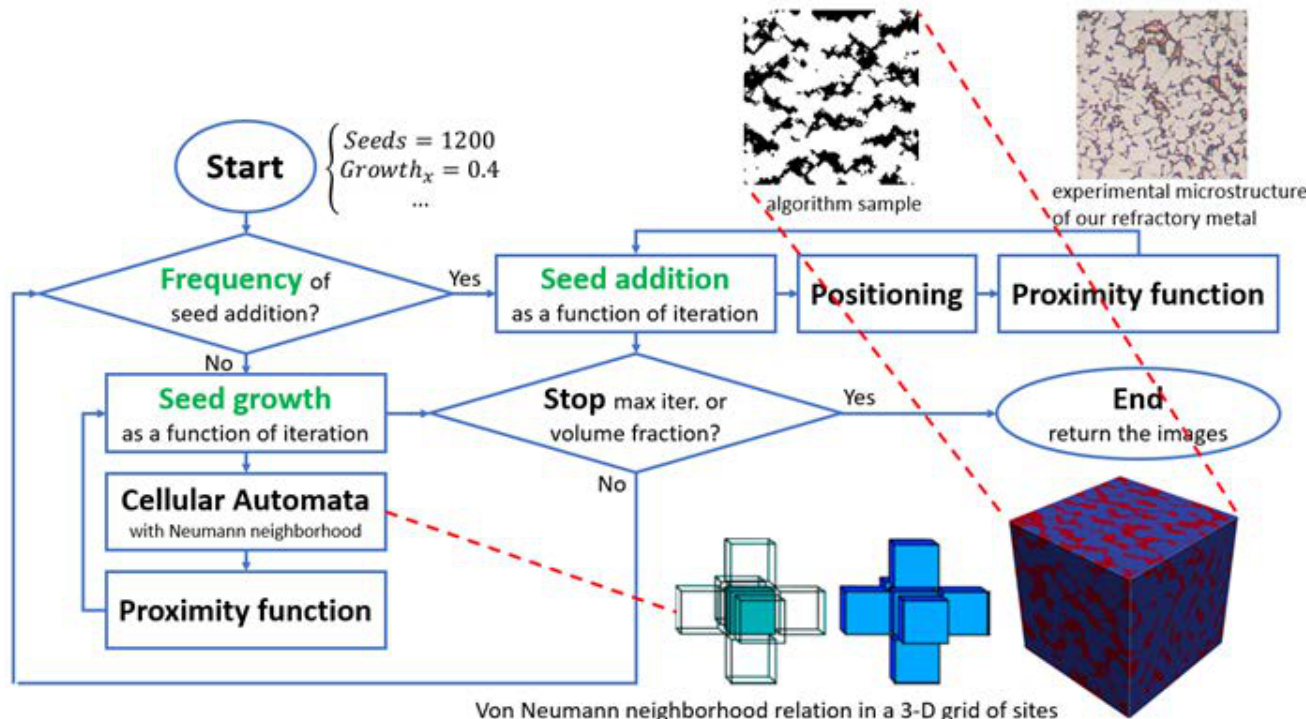
Table 1. Input variables of microstructure realization: the initial values for the test phase and the final values for generating the data set.